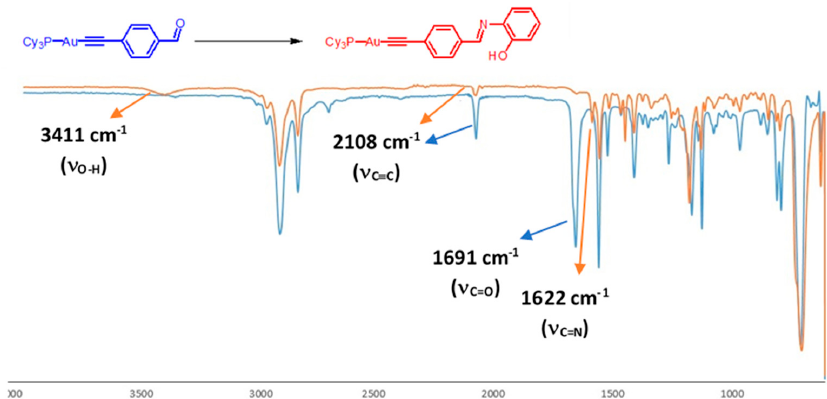
Figure 4. The changes in the IR spectra upon reacting 2 with 2-aminophenol to produce 5. Table 1. Bond lengths (Å) for complexes 2 and 5.